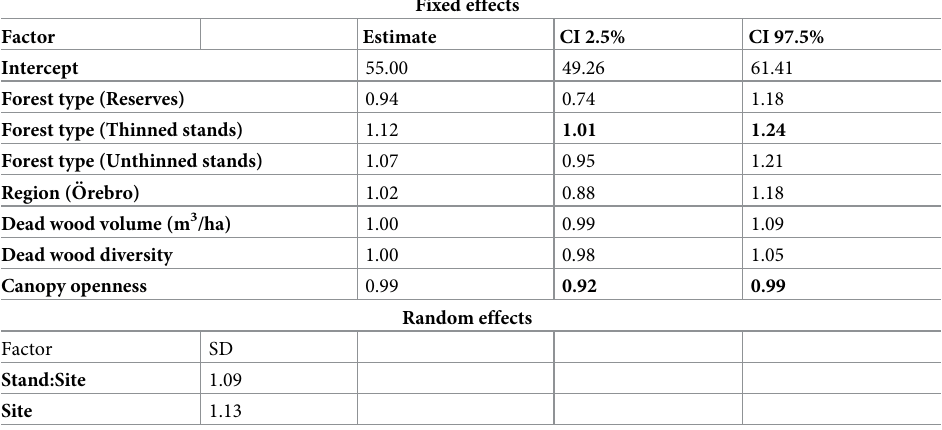
Table 3. Saproxylic alpha diversity and environmental factors. GLMM results for all saproxylic species. For the cat- egorical predictors “Forest type” and “Region”, Woodland Key Habitat (WKH) and Jo¨nko¨ping are the respective refer- ence levels. The continuous predictors (Dead wood volume, Dead wood diversity, Canopy openness) have been unstandardized and all values have been back-transformed, giving odds ratios for the fixed effect estimates. The ran- dom factor “Stand” is nested within “Site”. Confidence intervals (CI) not overlapping 1 (indicating statistical signifi- cance) have been marked in